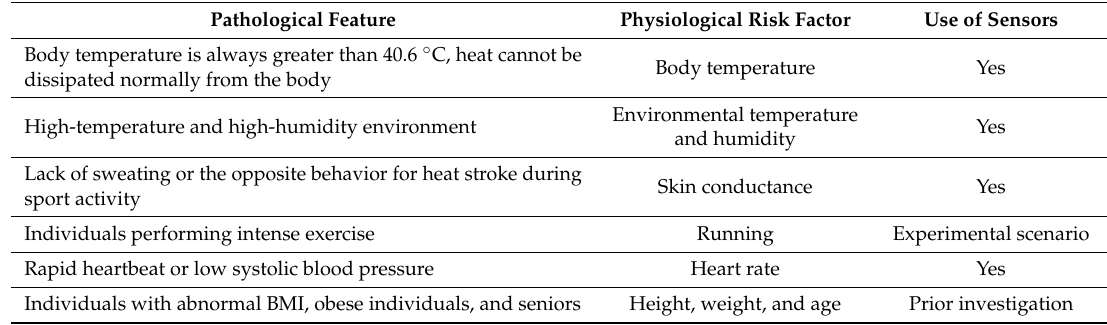
Table 1. Pathological features and the corresponding physiological risk factors of heat